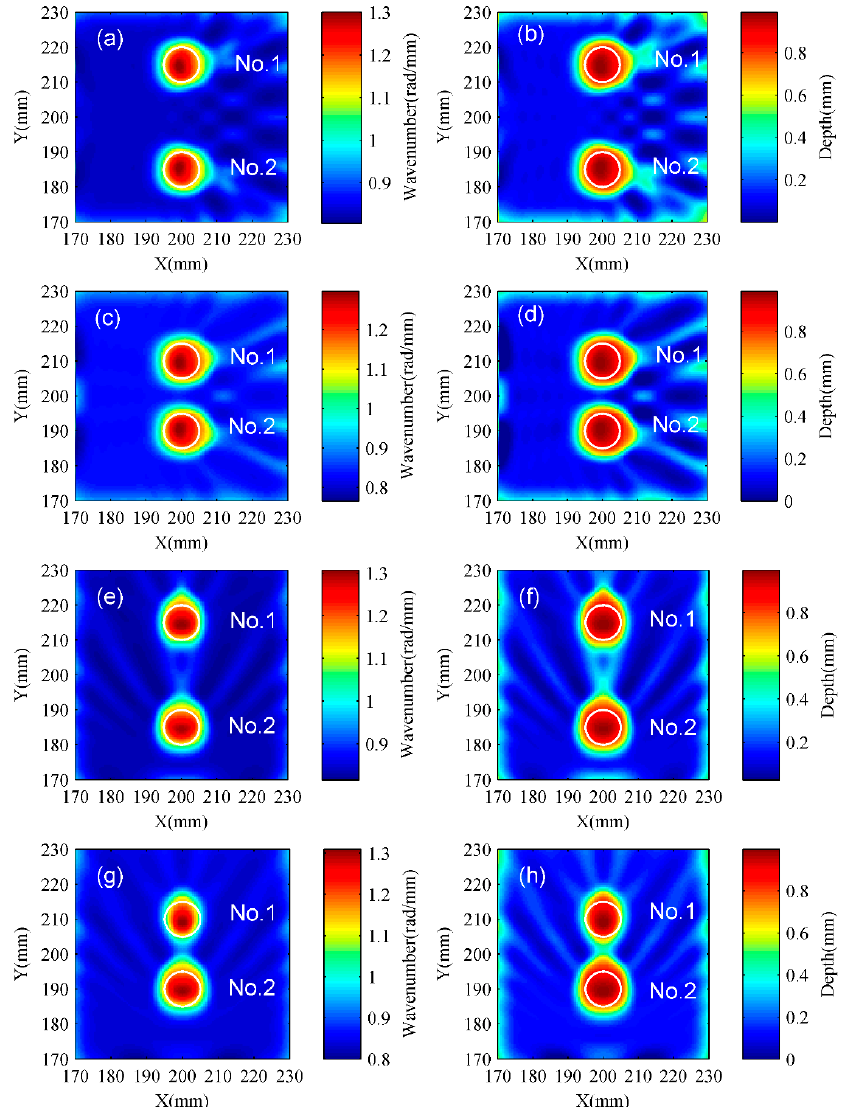
Figure 12. Simulation results of Case 4 to Case 7. ( a ) Wavenumber distribution of Case 4; ( b ) depth distribution of Case 4; ( c ) wavenumber distribution of Case 5; ( d ) depth distribution of Case 5; ( e ) wavenumber distribution of Case 6; ( f ) depth distribution of Case 6; ( g ) wavenumber distribution of Case 7; ( h ) depth distribution of Case 7. The white circle represents the actual location of the damage. The actual depth of the defect is 1 mm.